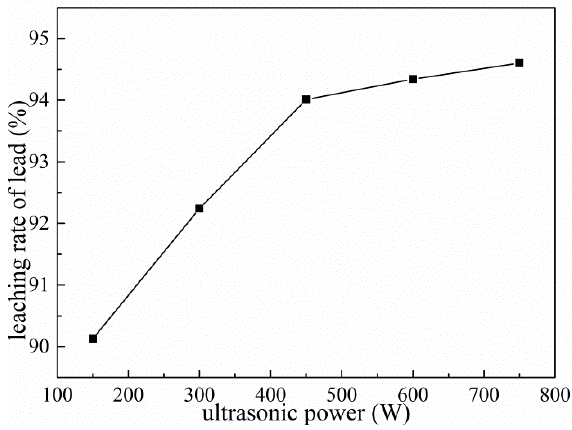
Figure 13. Effects of ultrasonic power on leaching of Pb. Figure 13. E ff ects of ultrasonic power on leaching of